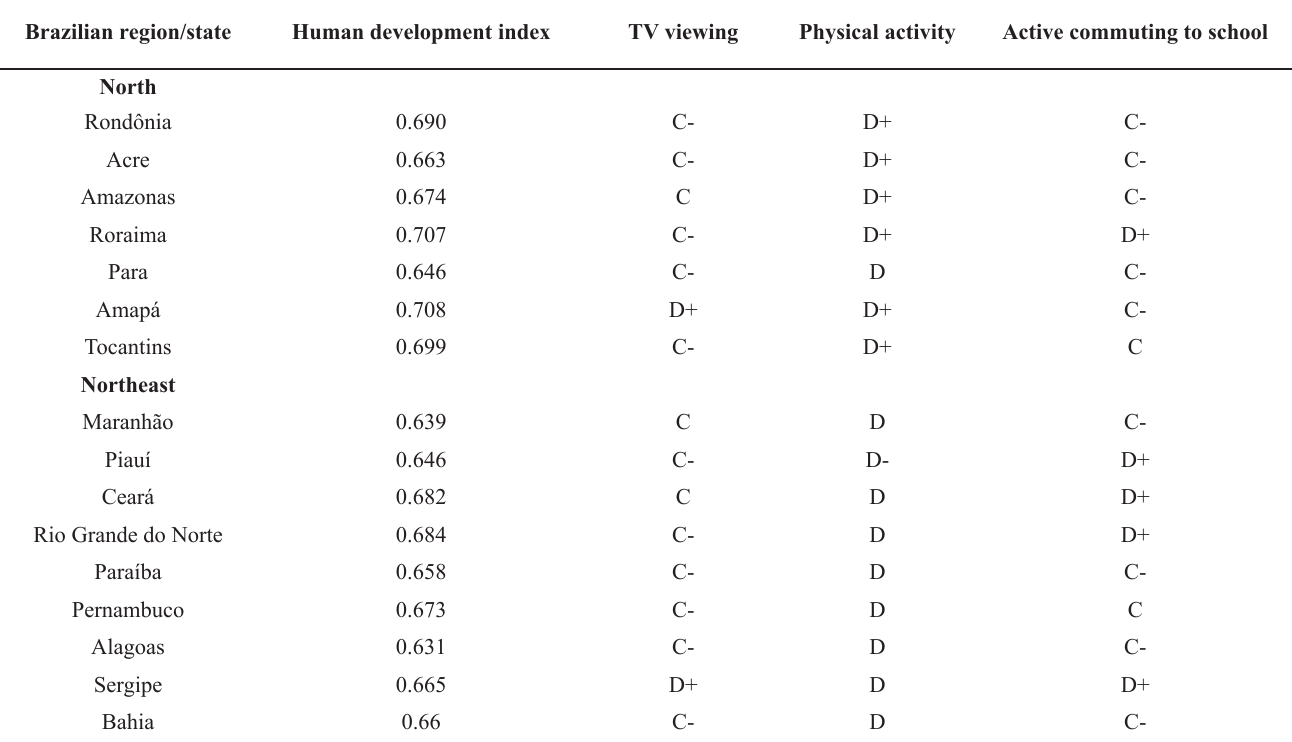
Table 2- Sociodemographic data from all Brazilian states and their respective grades of TV viewing, total physical activity, and active commuting to